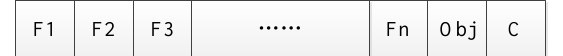
Figure 2. Code Figure 2. Code structure.